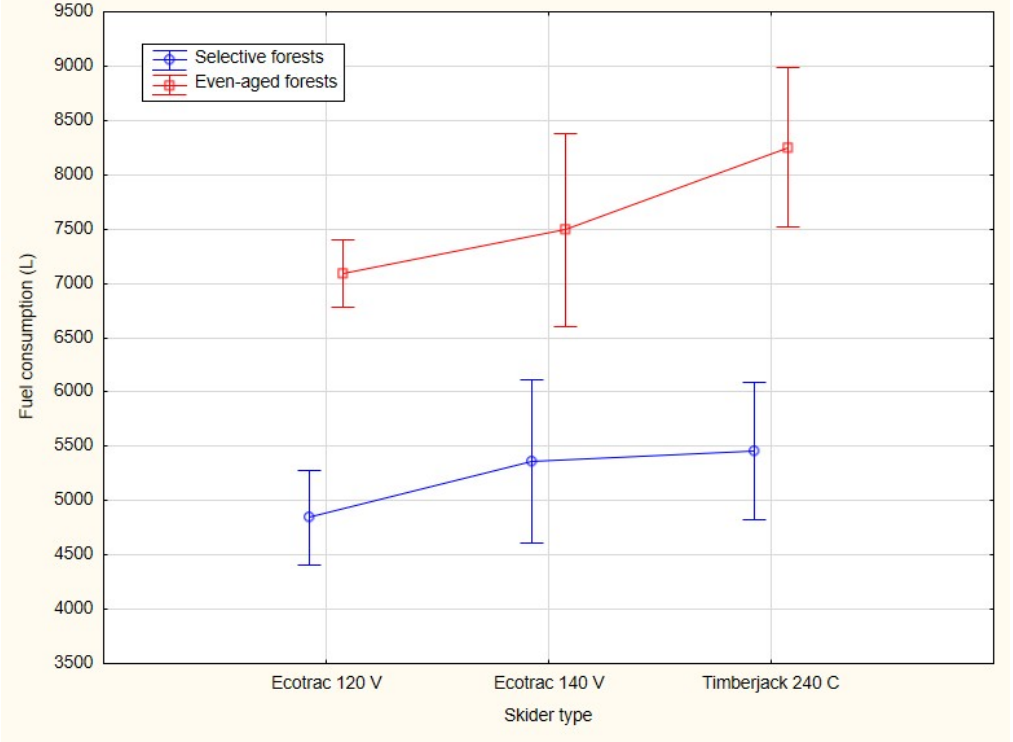
Figure 5. Total average fuel consumption of skidders.